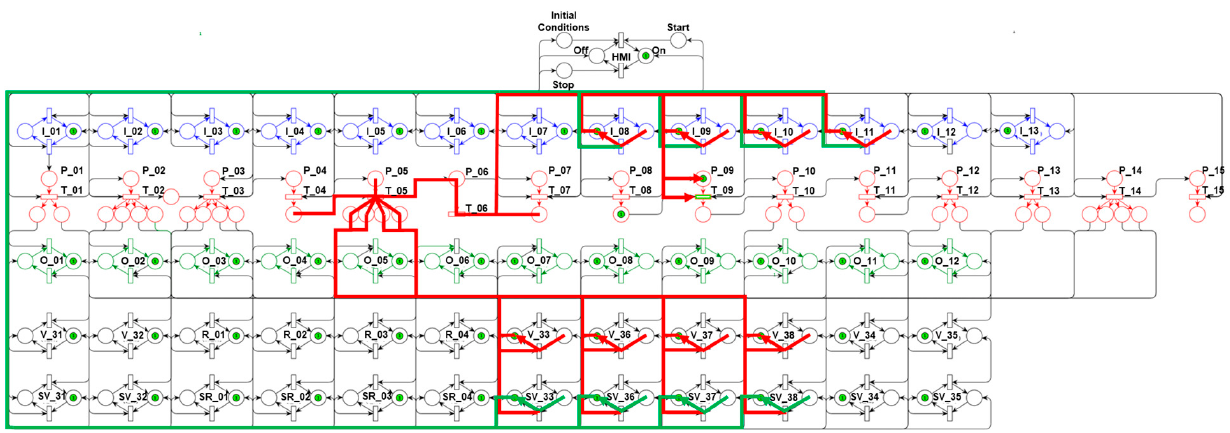
Figure 26. Algorithm’s 10th step—Close valves.